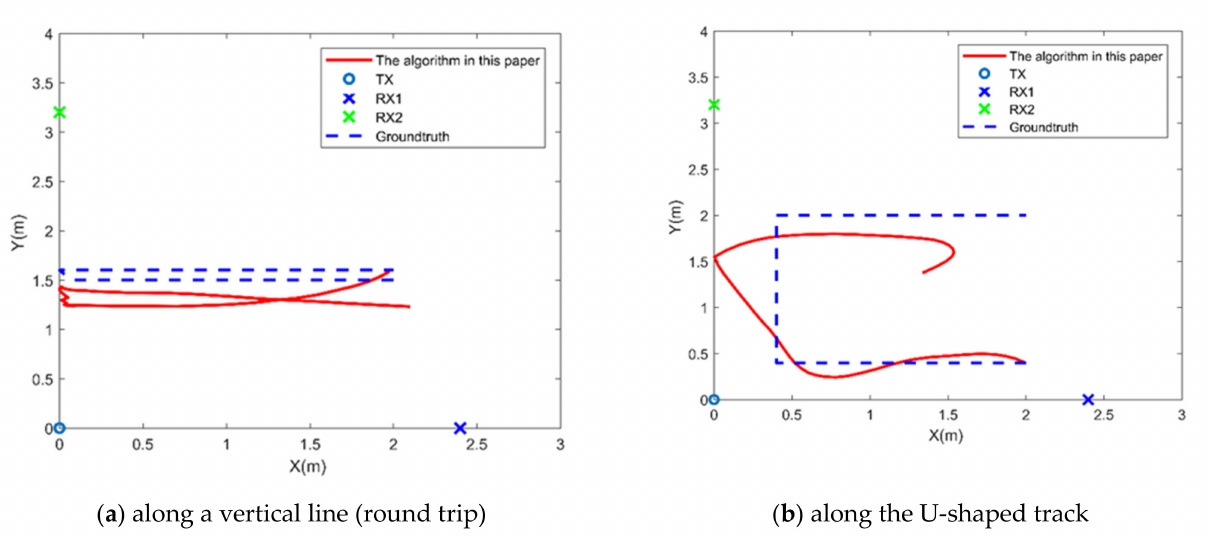
Figure 10. The trajectory prediction of a person walking in Environment 1. Figure 11a,b is the measured trajectories of a person walking along with the circular and the vertical line tracks in Environment 2. The mean error of different trajectories in Environment 2 is 0.20 m. The maximum error of different trajectories in Environment 2 is 0.50 m. Environment 2 does not have any furniture. Compared with Environment 1, Environment 2 has much less multipath, so the average error is smaller.